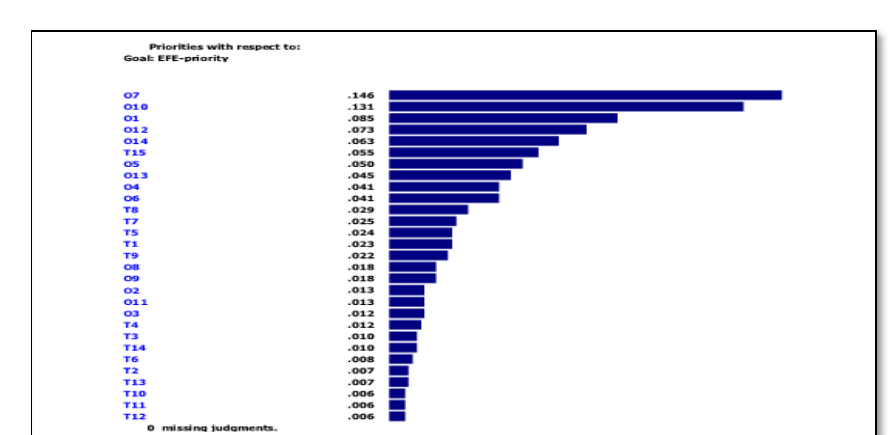
Fig. 5: External factors of existing environment factors by AHP and EC